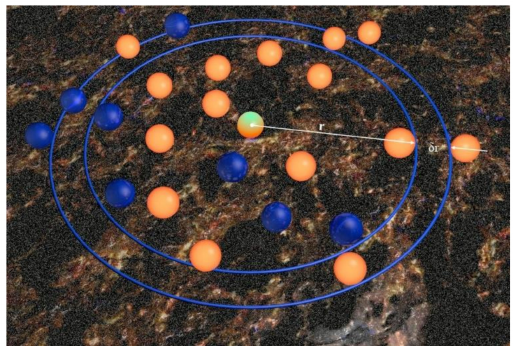
Figure 14. Diagram of particle radial distribution function. The intra- and intermolecular radial distribution functions of SEUG with different degrees of cross-linking were calculated as shown in Figures 15 and 16, respectively.